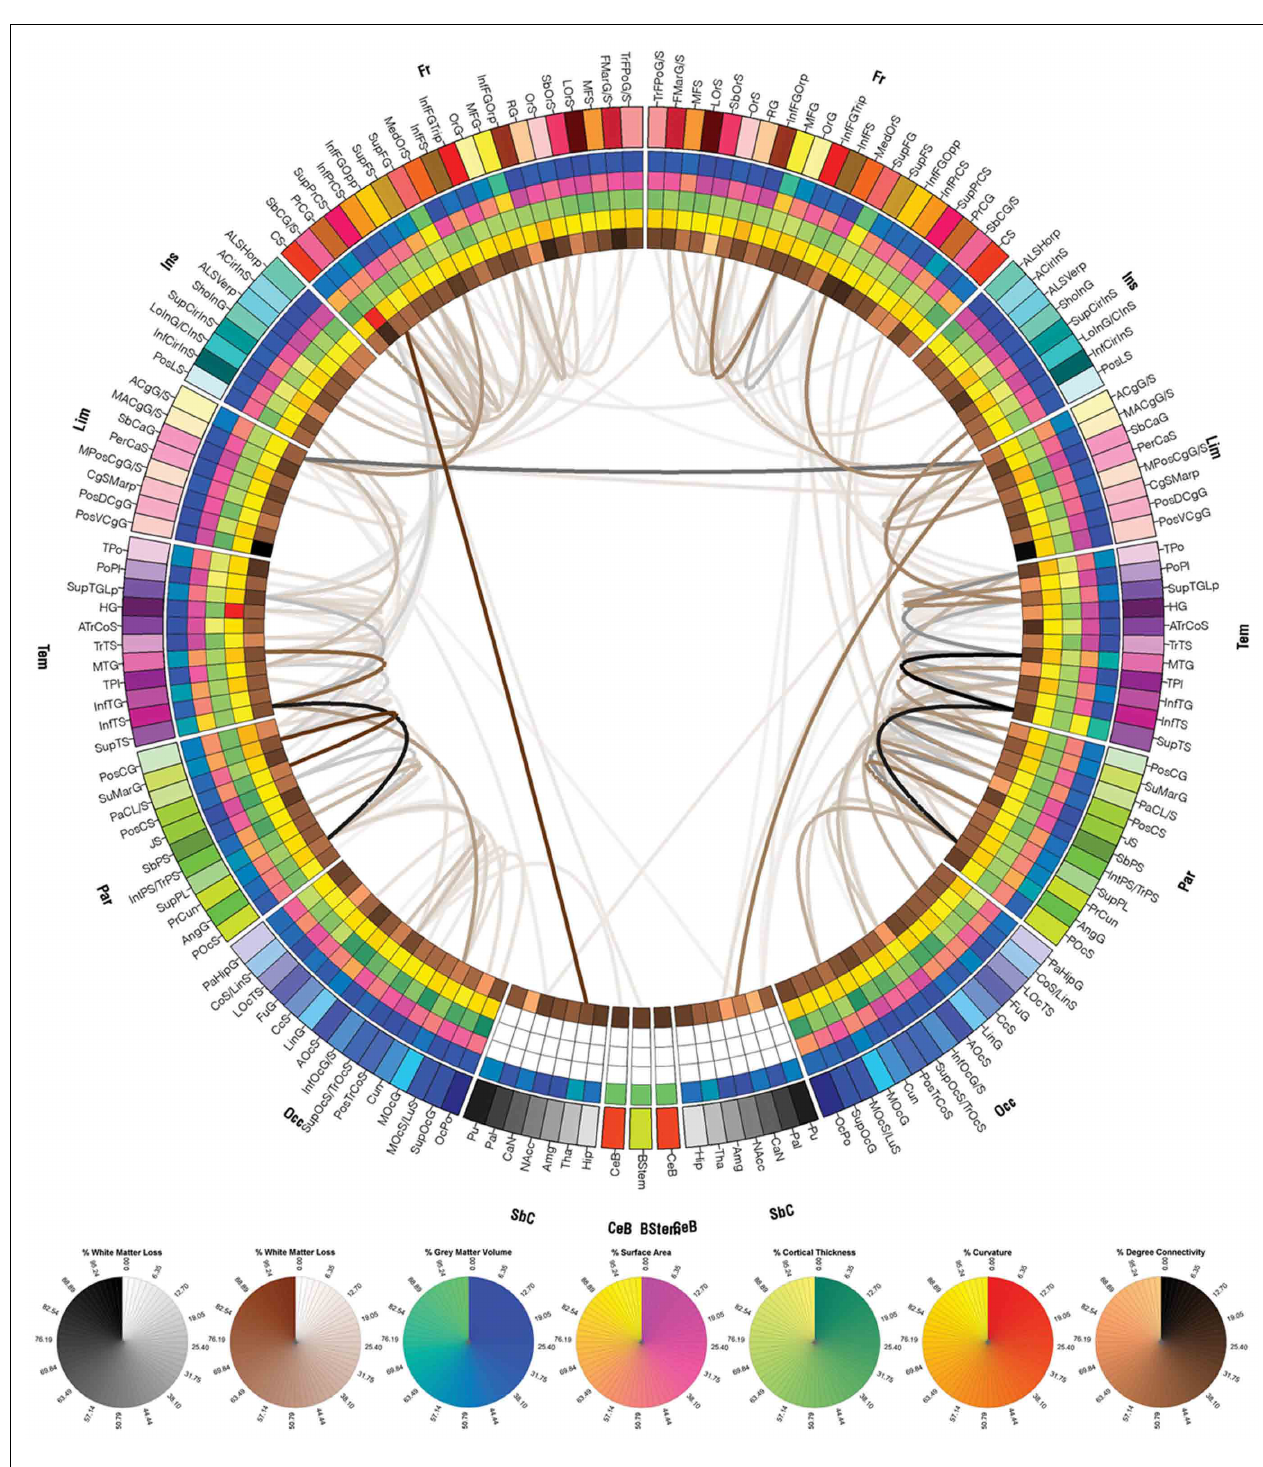
the automatic segmentations of pathology shown in Figure 2 . Similarly, gray links indicateWM fibers between two regions that were both affected. Circular color maps are displayed below the connectogram for links (first two maps, white to brown and white to black) and for the metrics encoded on the five innermost rings of the connectogram.The range for each of these metrics is from their minimum to their maximum assumed